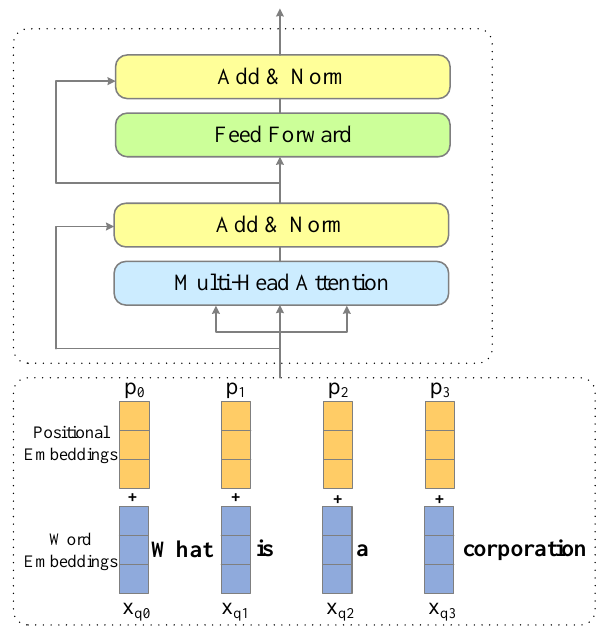
Figure 10. Using the Transformer to extract features of